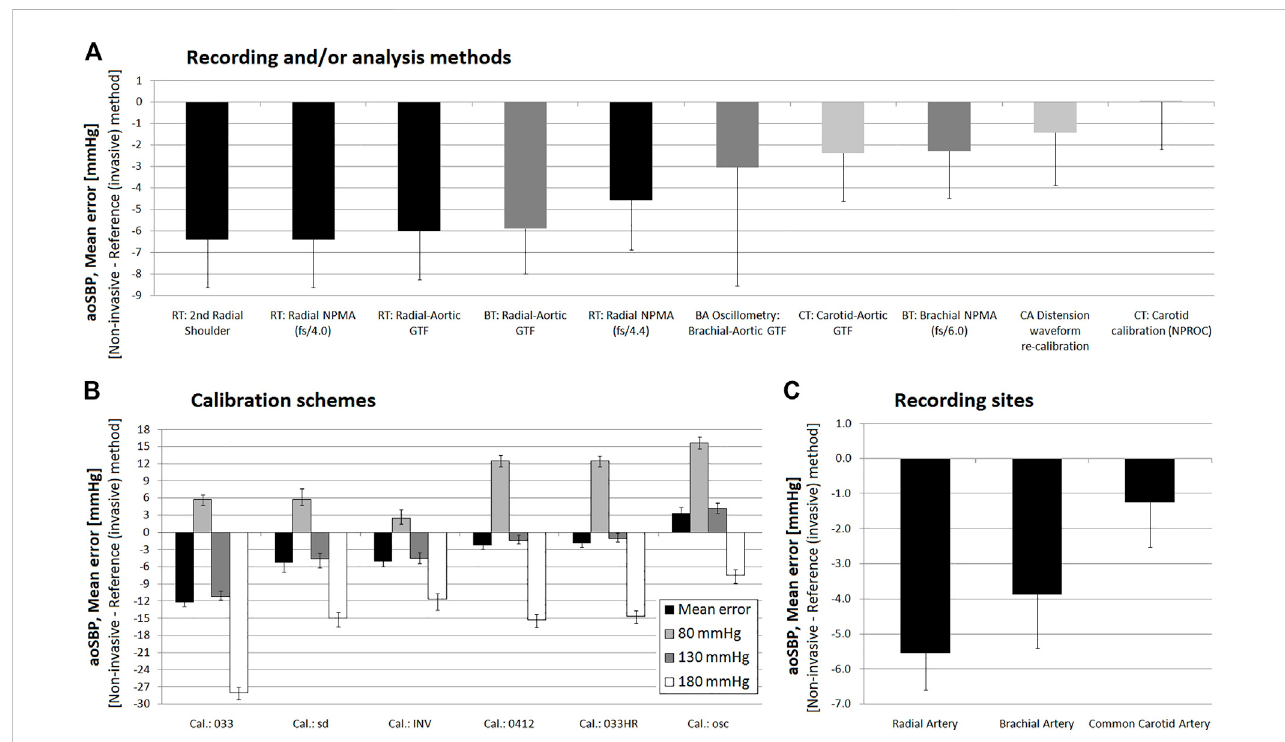
FIGURE 7 Pooled results for Bland-Altman derived mean errors (and lower or upper 95% con fi dence limits) obtained for comparisons between non-invasive and invasive aoSBP measurements. Results grouped according to: (A) , recording and/or analysis method; (B) : calibration scheme; (C) : recording